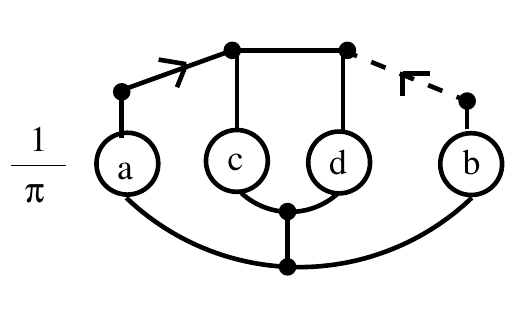
Figure 22 . P 3 ( a; b ; c; d ).